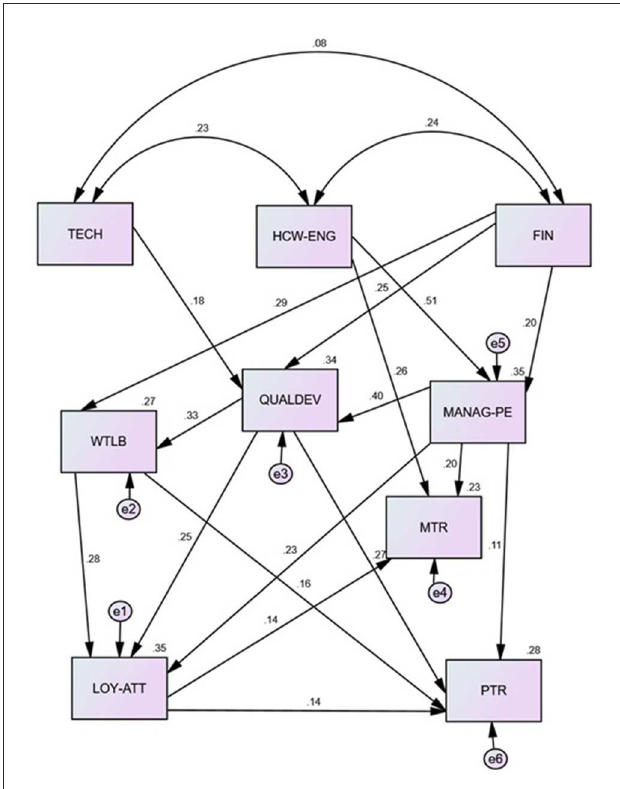
FIGURE5 Spearman correlation ( r ) between BSC-HCW1 factors (source: own elaboration). r < 0.2, negligible; ( r = 0.2–0.49), low; ( r = 0.5–0.69), moderate; ( r = 0.7–0.85), high; ( r = 0.86–1.00), very high. MANAG-PE, management performance evaluation; HCW-ENG, health care workers’ engagement; FIN, financial incentives; QUALDEV, quality and development; TECH, technology; WTLB, workload time-life balance; MTR, HCWs trusting their managers; PTR, perceived patient respect and trust attitudes toward health care workers; LOY-ATT, loyalty